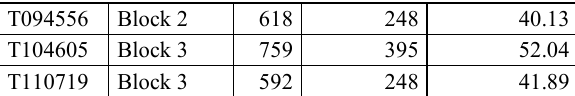
Table 4. % of images extracted from the Slantrange calibration procedure for Judean Foothill data acquisition performed on